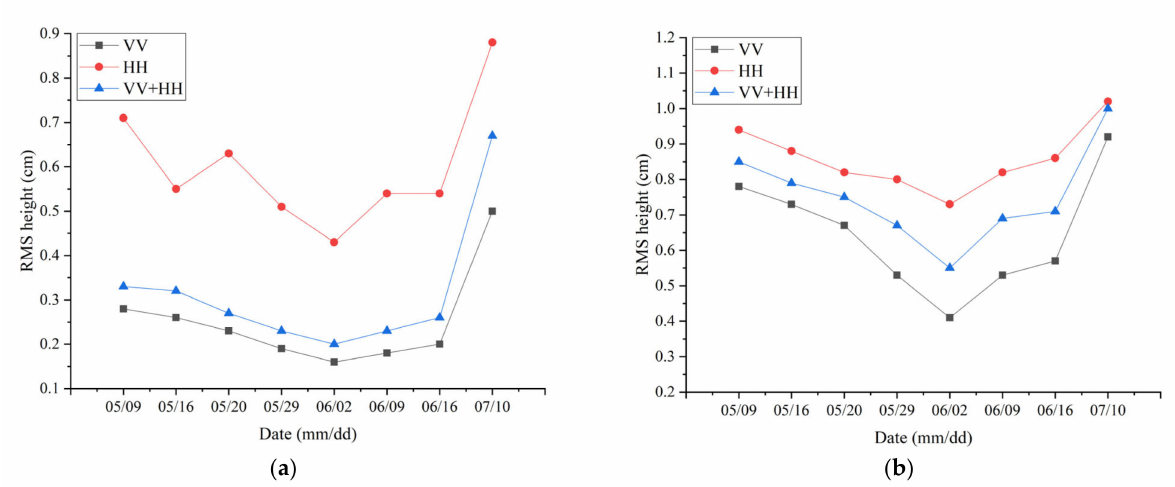
Figure 11. Time series variation of effective roughness parameters ( a ) CIEM; ( b ) Dubois